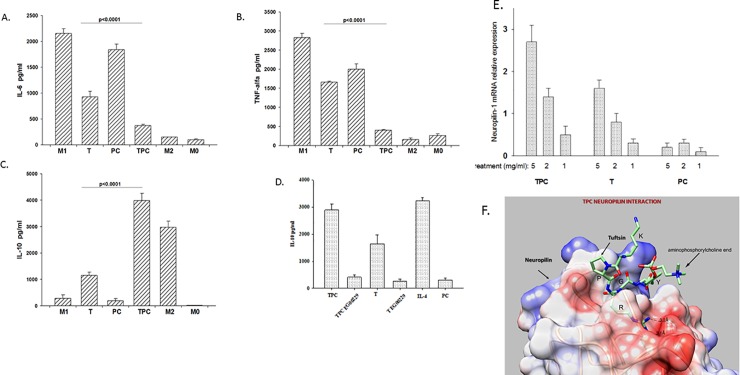
Cytokine expression in polarized RAW cells macrophages.In vitro analyses of concentrations of the pro-inflammatory cytokines IL-6, TNF-α, and the anti-inflammatory cytokine IL-10 in the culture fluids of M1 polarized RAW cells macrophages incubated with tuftsin-phosphoryl choline (TPC), tuftsin (T) and phosphorylcholine (PC). The data are presented as concentration in pg/ml. Values are the mean±SD, P < 0.001. [A] In vitro analyses of the pro-inflammatory cytokine IL-6 concentration. [B] In vitro analyses of the pro-inflammatory cytokine TNF-α concentration. [C] In vitro analyses of the anti-inflammatory cytokine IL-10 concentration. [D] TPC manipulate the shift from M1 toward M2 via neuropilin receptor. M1 RAW macrophages were incubated with neuropilin inhibitor EG00229, before adding TPC, T, and PC. The data are presented as mean ± SD of three repeated experiments (P < 0.001). [E] The effect of TPC on neuropilin mRNA expression in RAW cells by RT-PCR. The data are presented as mean ± SD of three repeated experiments. [F] Model structure of the TCP neuropilin complex. Tuftsin is shown as a stick diagram with carbon, nitrogen and oxygen atoms in green, blue and red, respectively. The surface of neuropilin is shown, colored by the electrostatic potential, blue for positive, red for negative and white for neutral. The surface was made transparent to show the binding of TPC residue R in a deep cavity and the bifurcated hydrogen bond between R and neuropilin residue D320.